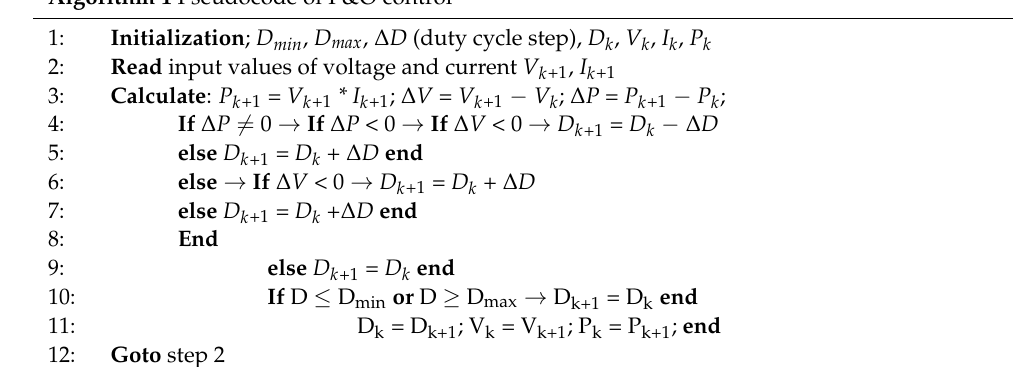
Algorithm 1 Pseudocode of P&O control